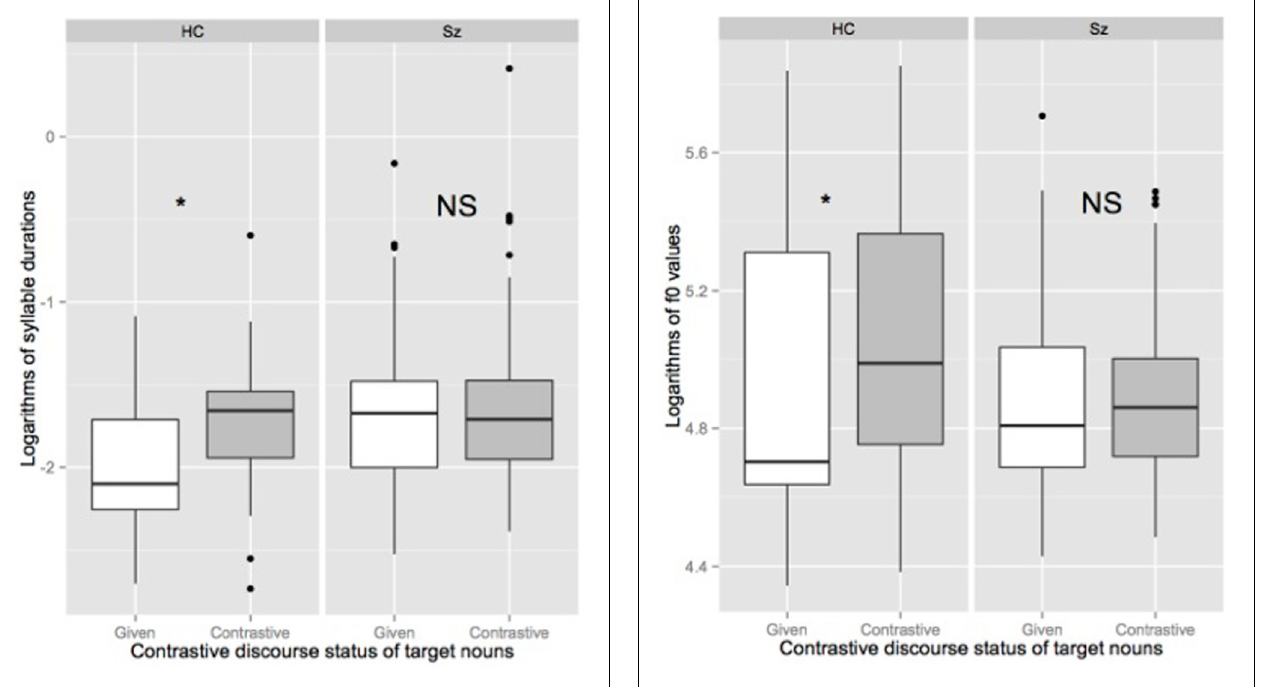
FIGURE 4 | Boxplot of logarithms of duration of target nouns’ last syllable produced by healthy controls participants (HC) and participants with schizophrenia (SZ) depending on their contrastive discourse (given vs. contrastive). The spacing between the different parts of the box indicates the degree of dispersion in the data. The bottom and top of the box represent the first and third quartiles, and the band inside the box corresponds to the second quartile (the median). Whiskers indicate the variability outside the upper and lower quartiles. Outliers are plotted as individual points. ∗ Significance level is set to < 0.05.